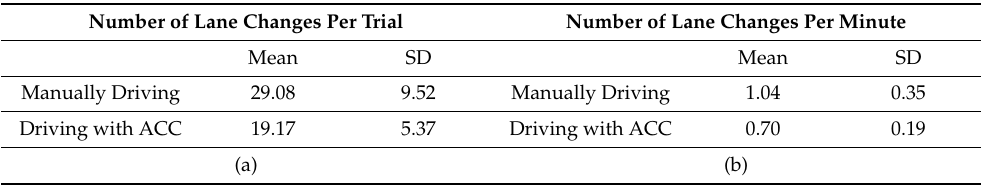
Table 1. Number of Lane Changes. (a) Mean number of lane changes per trial for the two driving conditions, (b) Mean number of lane changes per